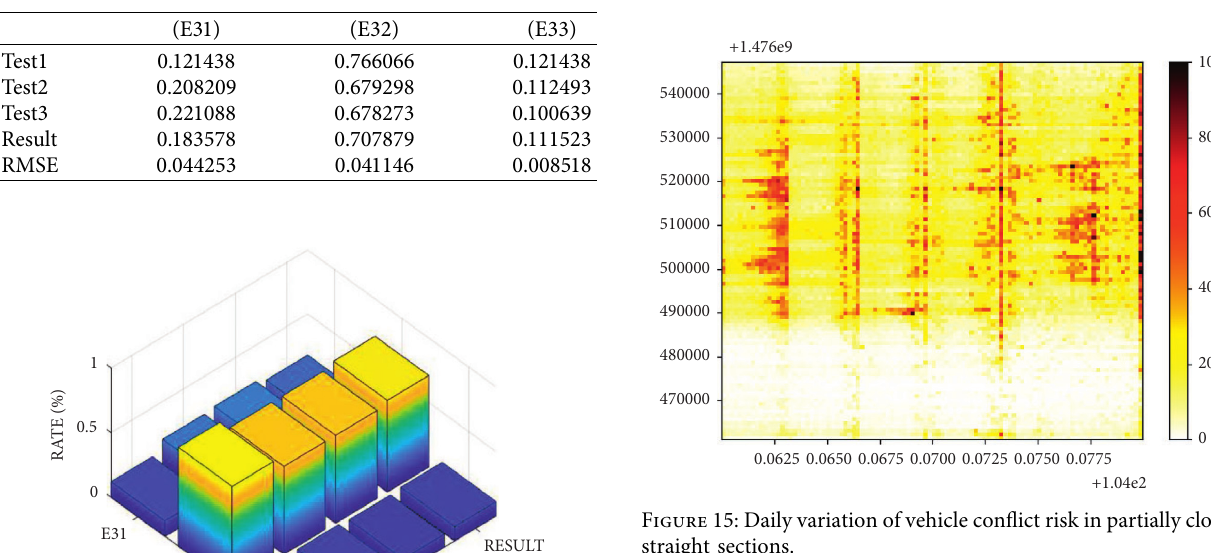
Figure 12: Proportion of each index of closed curve section. Table 5: Proportion of each index of vehicle entry section.